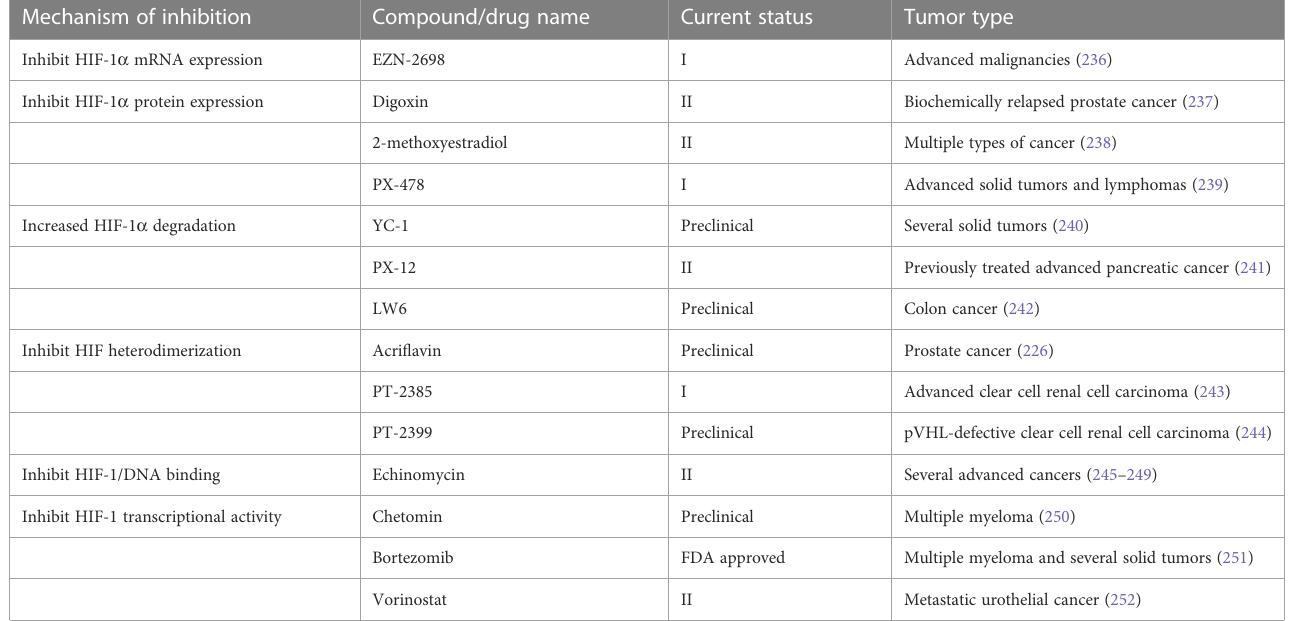
TABLE 5 Inhibitors directly targeting the HIF pathway in